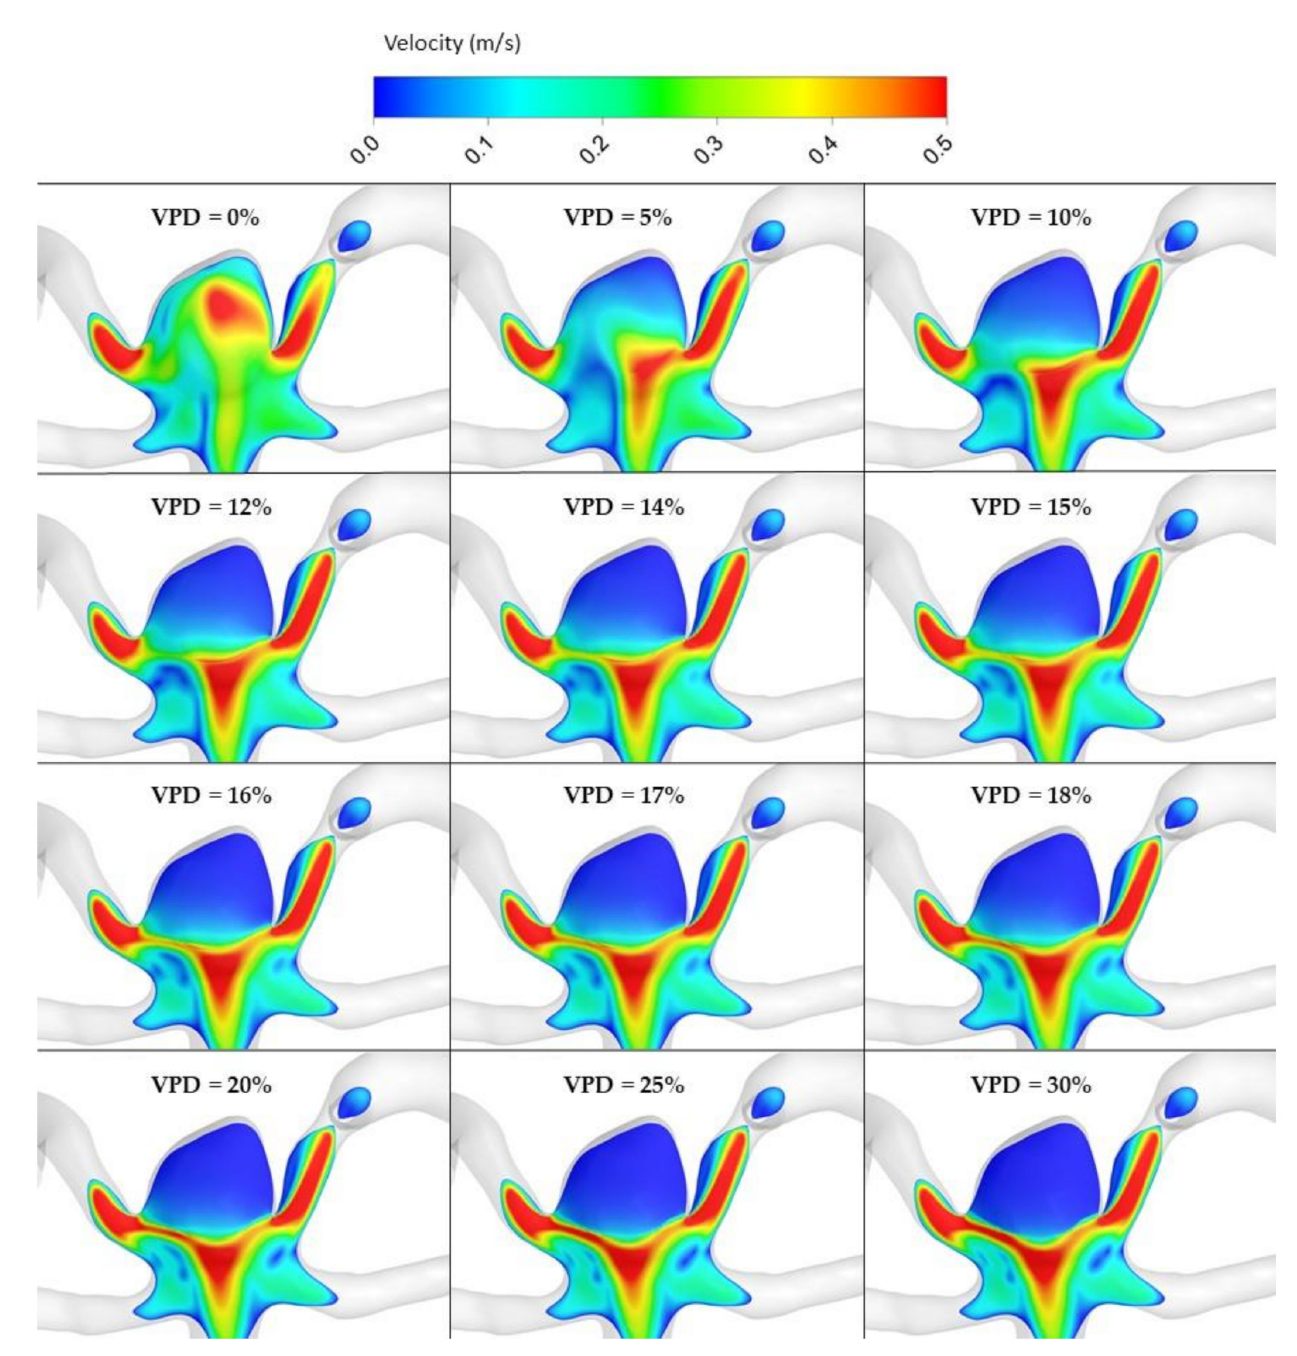
Figure 12. Velocity distribution at aneurysm cross section for selected VPD cases; stationary